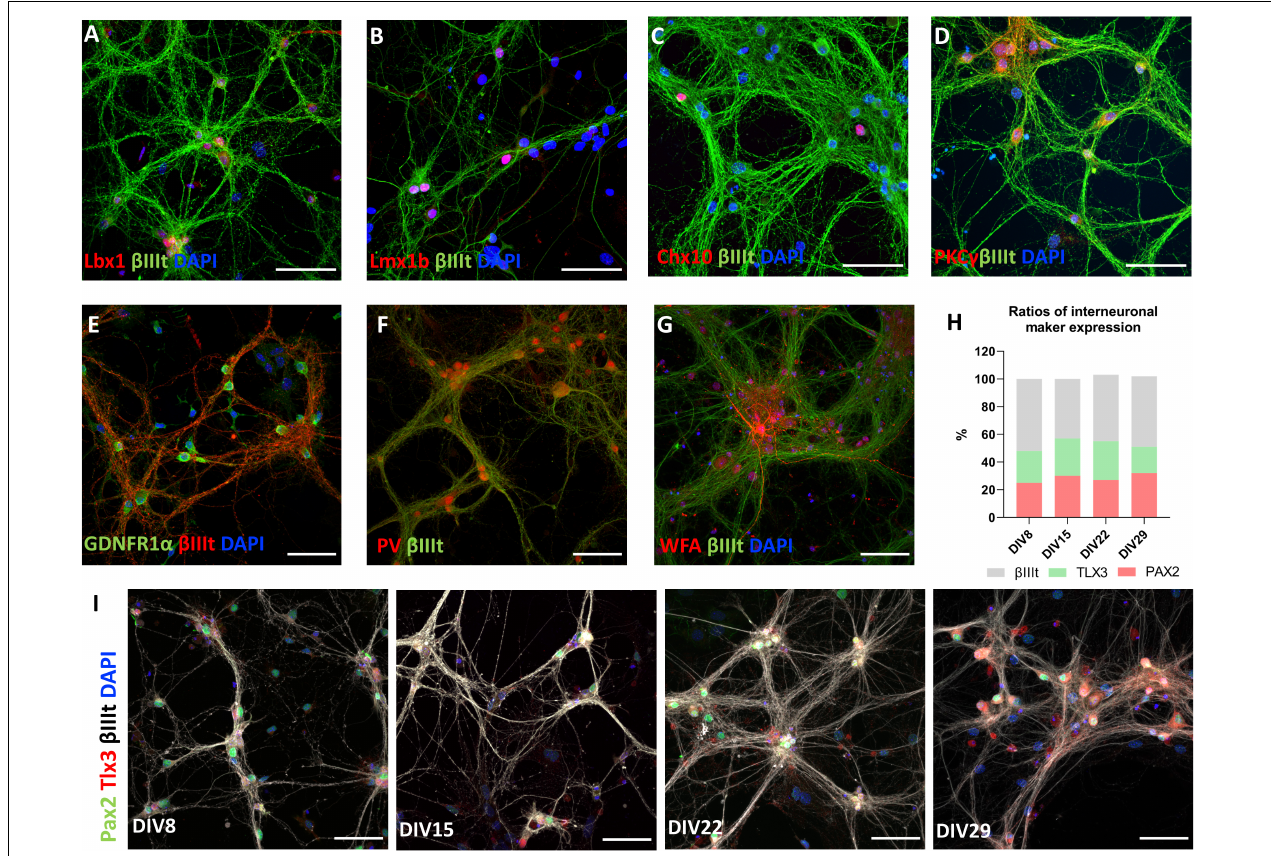
FIGURE 6 | Markers of spinal interneurons Lbx1 (A) , Lmx1b (B) , Chx10 (C) , Pax2, and Tlx3 (I) are present in primary spinal cord cultures. Pax2+ and Tlx3+ cells represent approximately half of neurons in the culture (H) . Neurons also expressed PKC γ (D) , GDNFR1 α (E) , parvalbumin (PV) (F) , and Wisteria floribunda agglutinin (WFA) (G) . Scale bars: 50 µ